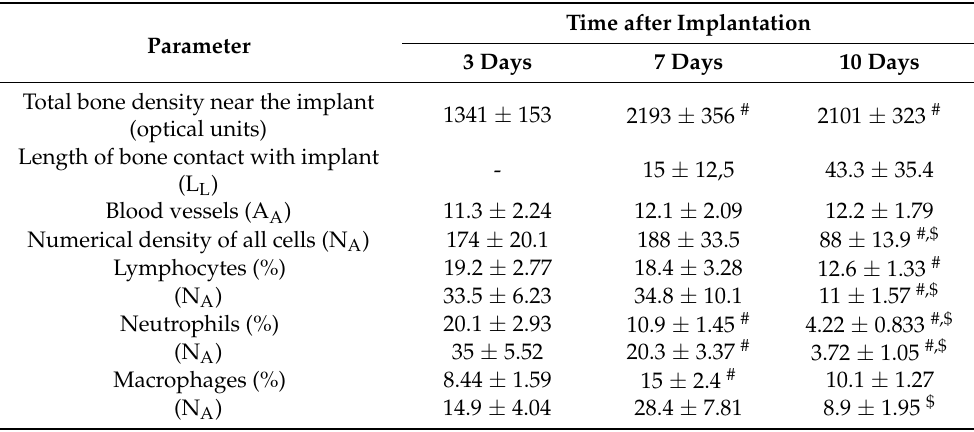
Table 1. Condition of the rabbit’s tissues from the proximal tibia condyle near the dental implants at control animals (S ± σ ).